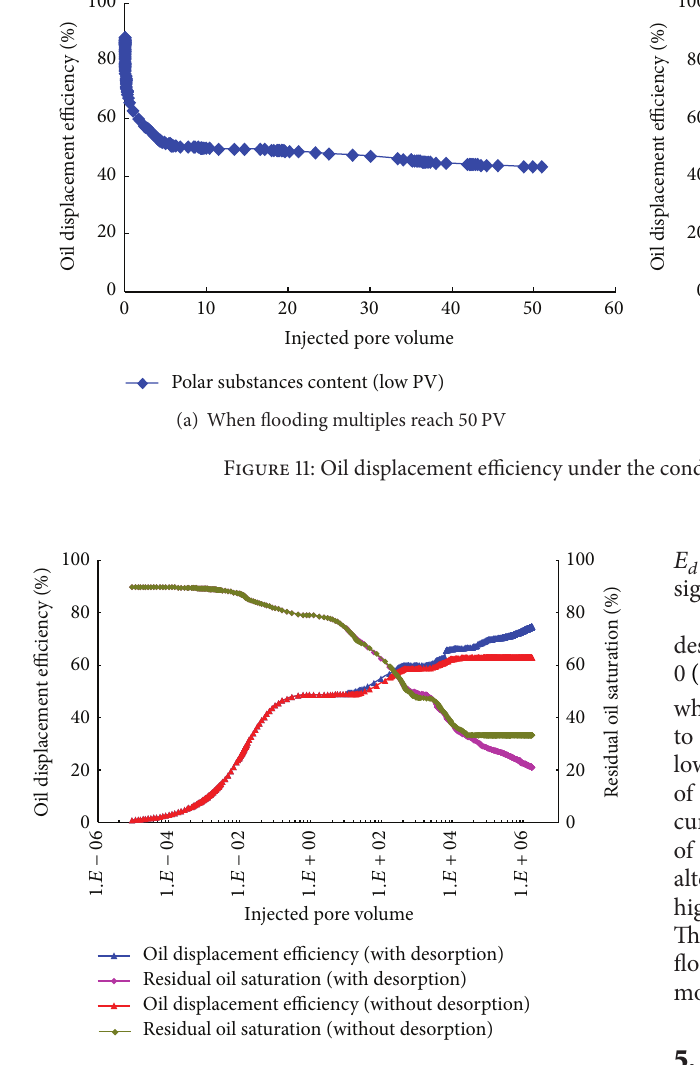
Figure 12: Relationship between water flooding multiples and oil displacement efficiency within different adsorption